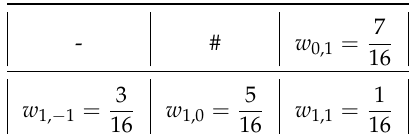
Figure 1. Error diffusion coefficients by Floyd–Steinberg [7].